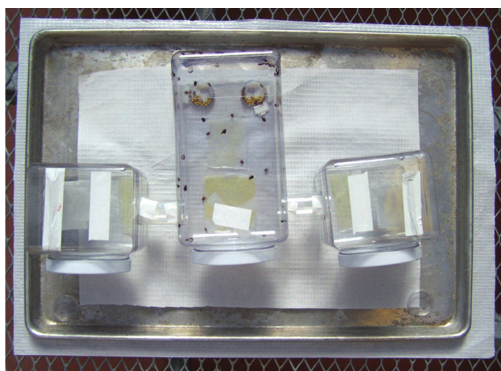
Table 2: E ff ects of crowding (of C . maculata females with or without males) on the mean ± SEM number of eggs laid and cannibalized per cage per